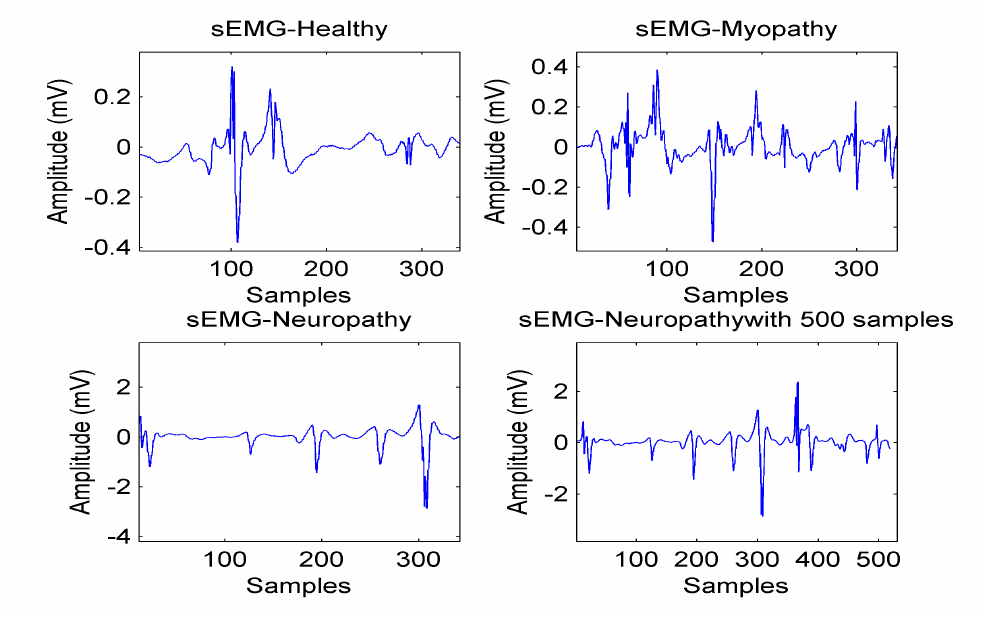
Figure 5. Healthy, neuropathy and myopathy sEMG signals.